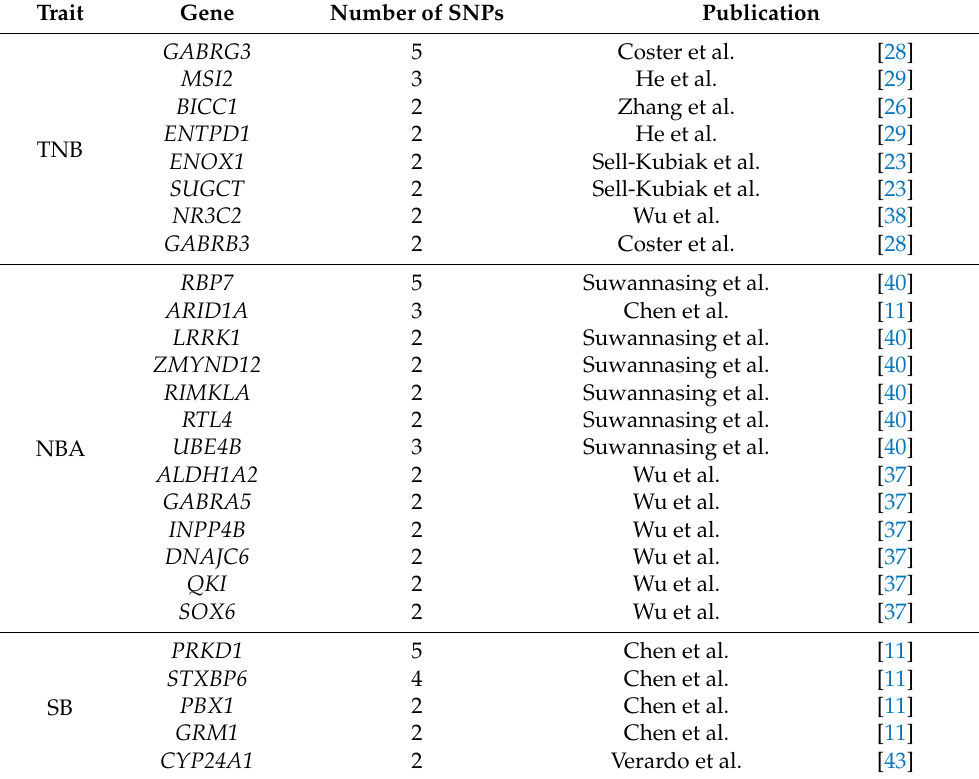
Table 3. Genes with at least two SNPs in their sequence associated with total number born (TNB), number born alive (NBA), or number of stillborn